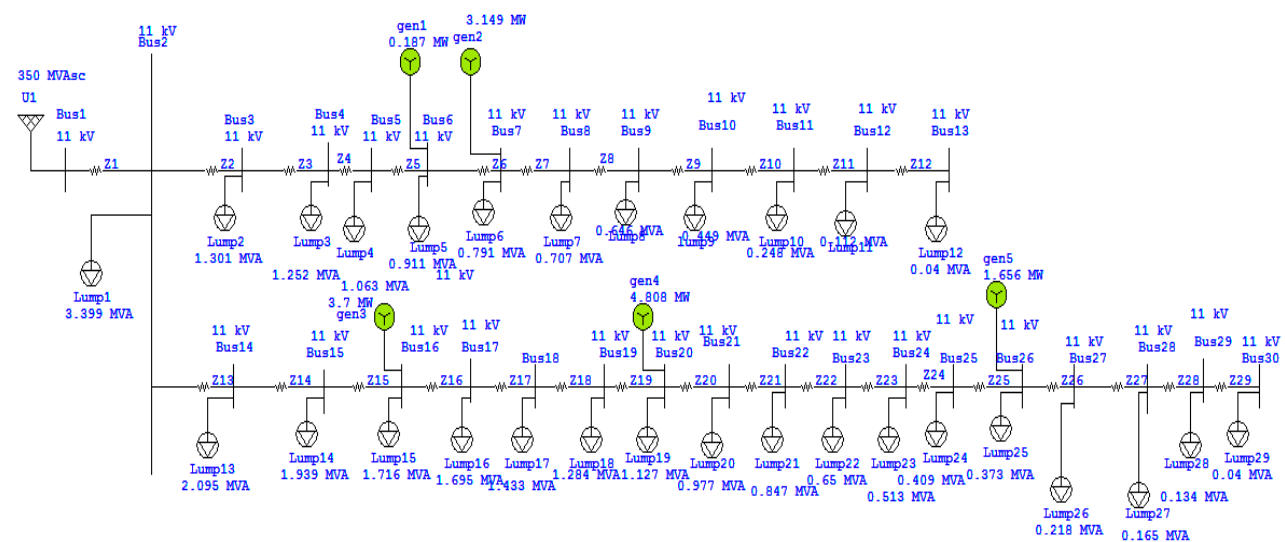
Figure 24. Tested distribution system simulated on ETAP with five DGs. Table 3. Fault current at different locations (8.26 × 10 6 per unit FCL).